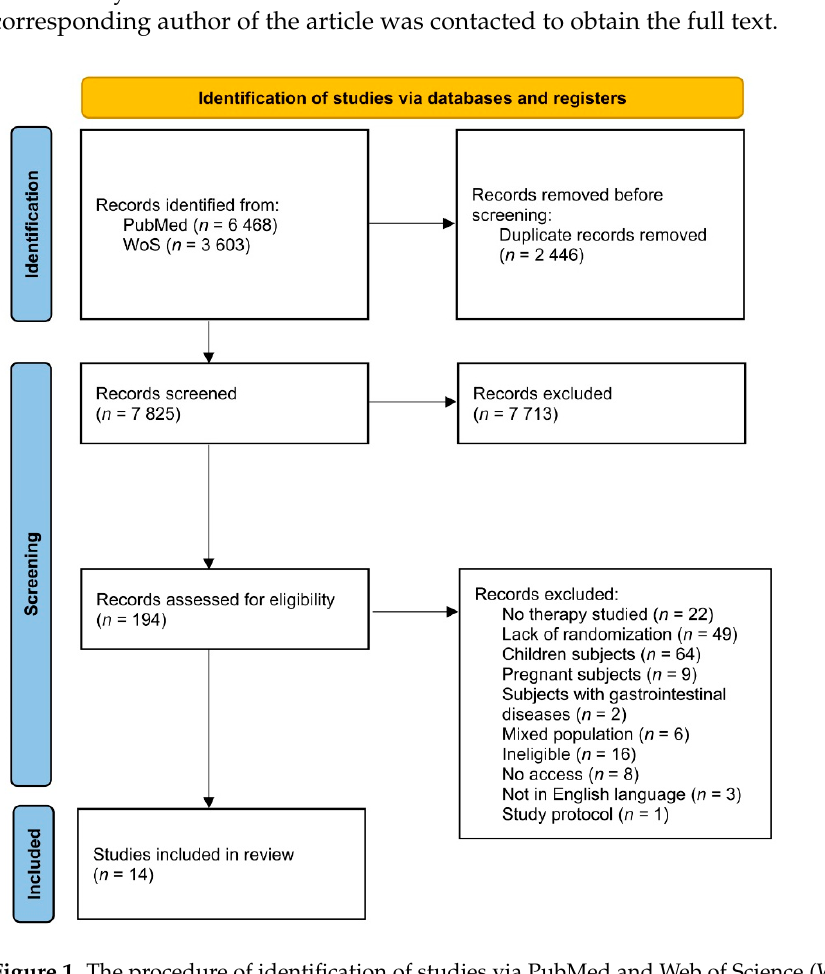
Figure 1. The procedure of identification of studies via PubMed and Web of Science (WoS) data- bases.